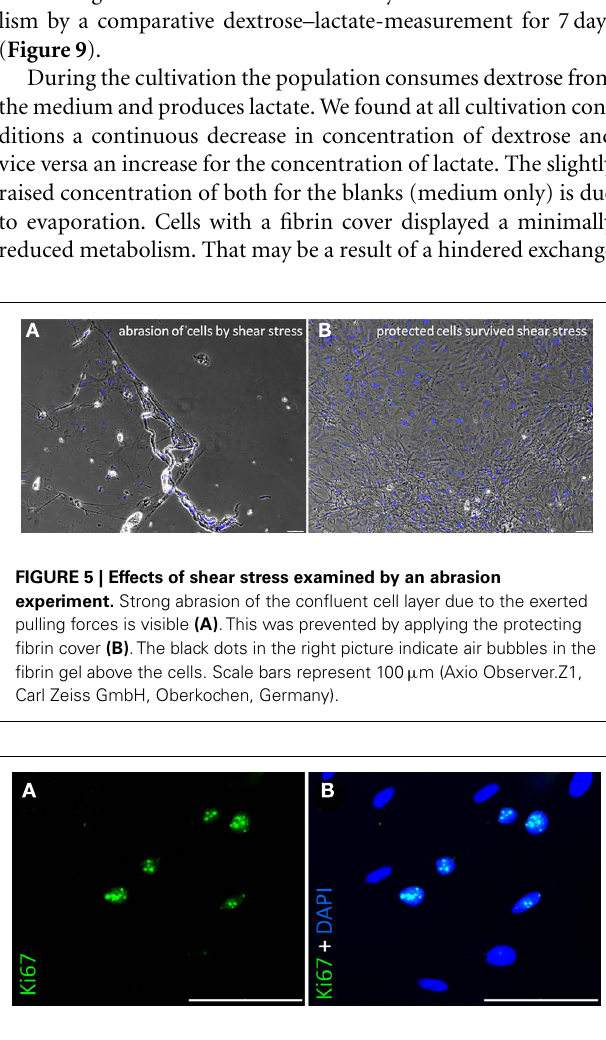
FIGURE 6 | Immunocytochemical staining of rat pancreatic stem cells for Ki67 grown on polyimide˚2 from ISIT. Nuclei were positively stained for Ki67 (A) and showed co-localisation with nuclear counterstain DAPI (B) . Scale bars represent 100 μ m (Axio Observer.Z1, Carl Zeiss GmbH, Oberkochen, Germany).